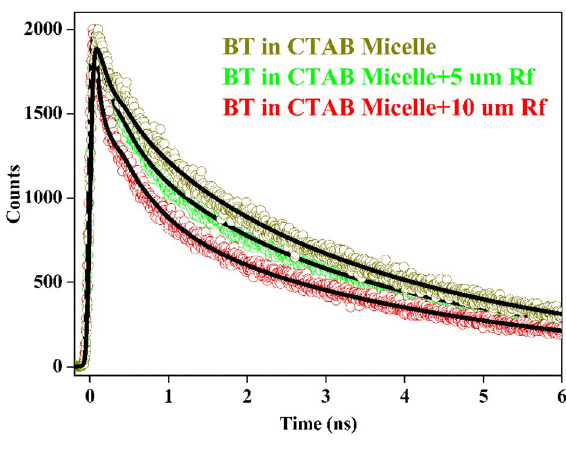
Figure 5. Time-resolved fluorescence transients of BT in CTAB in absence and in presence of two different concentration of RF. The bold line represents the fitting line of the curves by considering simplified infelta tachiya kinetic model of donor acceptor association in CTAB micelle.